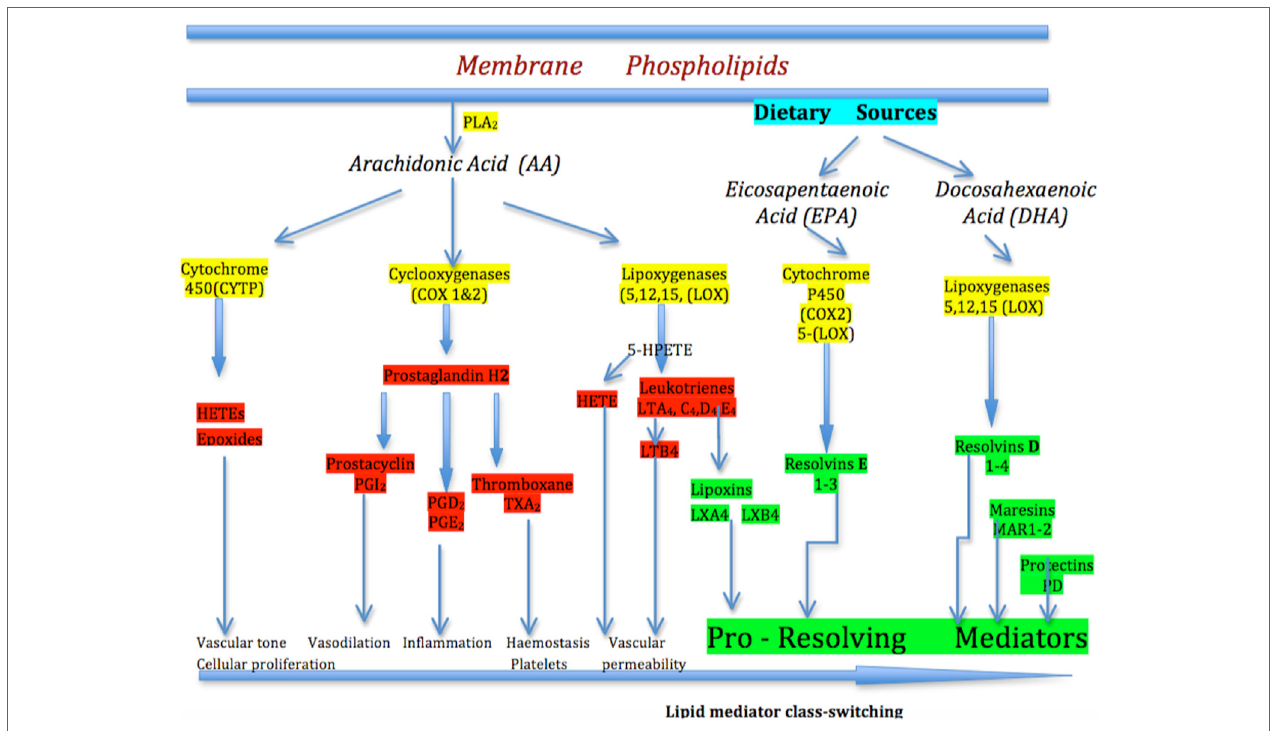
FigURe 2 | The arachidonic acid (AA) pathway of inflammation mediators. In the simplified pathway for the eicosanoid metabolic pathway, AA is released from membrane stores by phospholipase 2 (PLA 2 ). AA is metabolized to biological mediators by three enzymatic pathways: cyclooxygenase, lipoxygenase, and cytochrome P450. Each pathway contains enzyme-specific steps that result in a wide variety of bioactive compounds that drive the pro-inflammatory (prostaglandins) response. After lipid mediator class-switching at the height of inflammation, the pro-resolving mediators-lipoxins begin to drive inflammation resolution. Eicosapentaenoic acid and docosahexaenoic acid-derived from dietary sources produce the E-series of resolvins and D-series of resolvins, maresins, and protectins, respectively, which are important pro-resolving mediators in progressing the resolution of